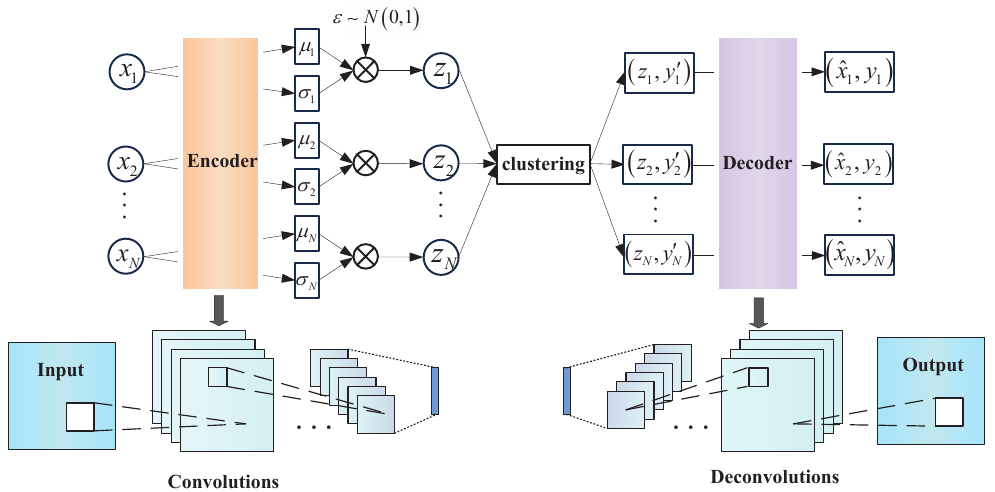
Figure 2. The improved VAE